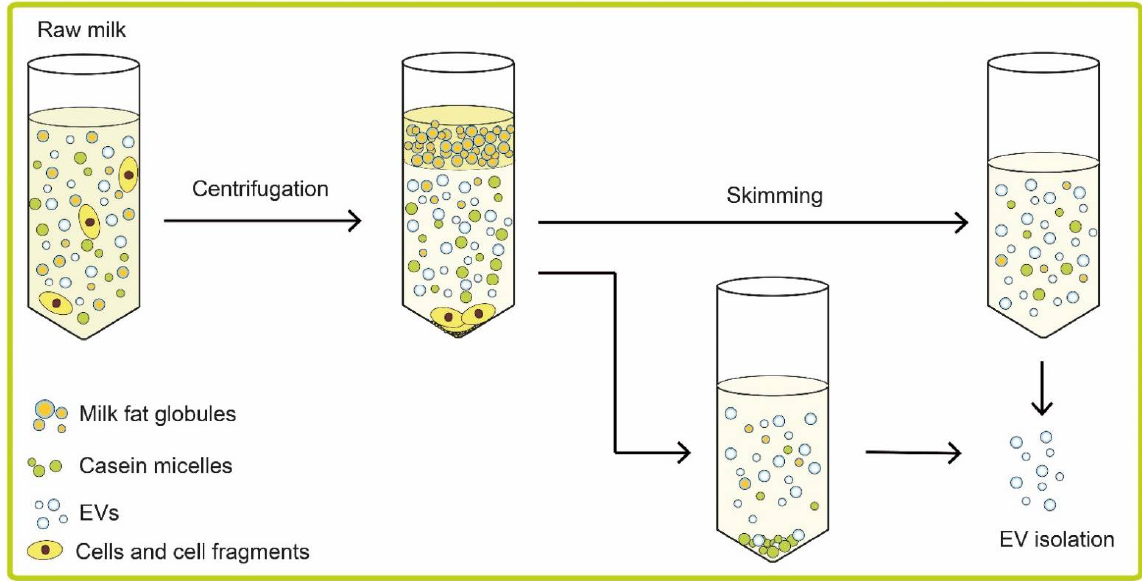
Figure 1. Processing of milk before isolation of extracellular vesicles. Raw milk contains cells, cell fragments, milk fat globules, casein micelles, and extracellular vesicles (EVs). As a first step, cells, cell fragments and milk fat globules are mostly removed by centrifugation. Milk fat globules will float to the top due to their low density, and cells and cell fragments will form a pellet. The middle layer contains casein micelles and EVs. This middle layer is the starting material for the isolation of EVs. Casein micelles can be removed by acid-induced or enzyme-induced precipitation, centrifugation, or by EDTA-induced dissociation.